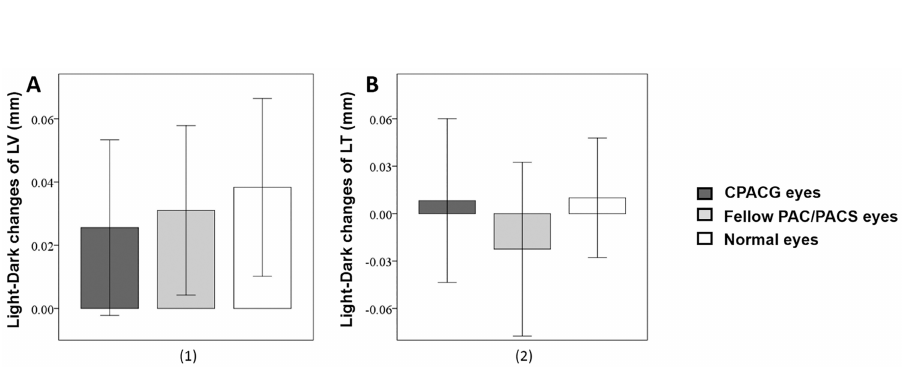
Fig 4. Light-to-dark changes of lens parameters in CPACG eyes, fellow PAC/PACS eyes, and normal eyes. A: There was no difference in light-to-dark changeof LVs amongthe three groups. B: There was no difference in light-to-dark change of LTs amongthe three groups. CPACG: chronic primary angle closure glaucoma;PAC: primary angle closure; PACS: primary angle closuresuspect; LV: lens vault; LT: lens thickness; Error bars: 95% confidenceinterval (95%